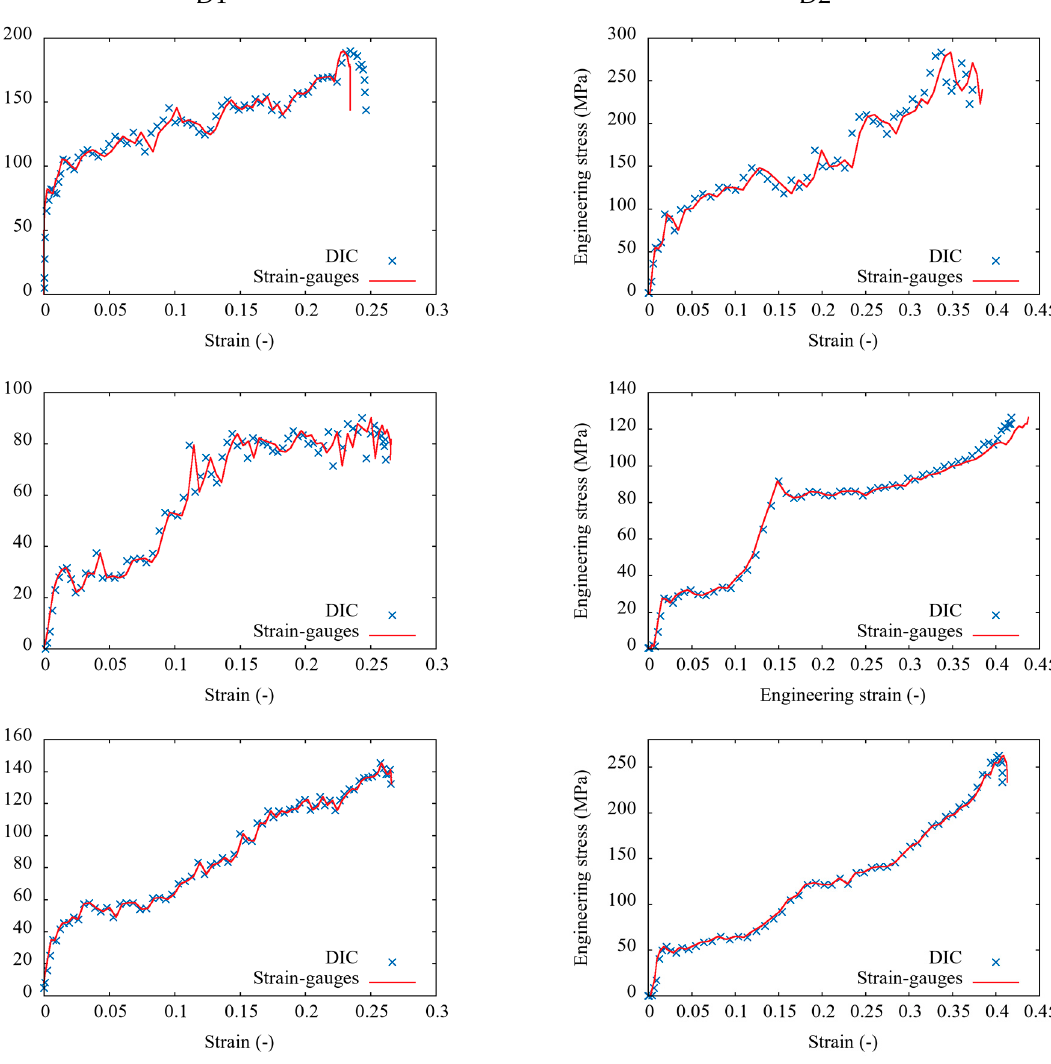
Figure 8. The dynamic engineering stress-strain relationships at lower (D1) and higher (D2) impact velocity, obtained by digital image correlation (DIC) method and strain-gauge measurements: ( a ) hexa-chiral 2D, ( b ) tetra-chiral 2D, and ( c ) tetra-chiral 3D structure.